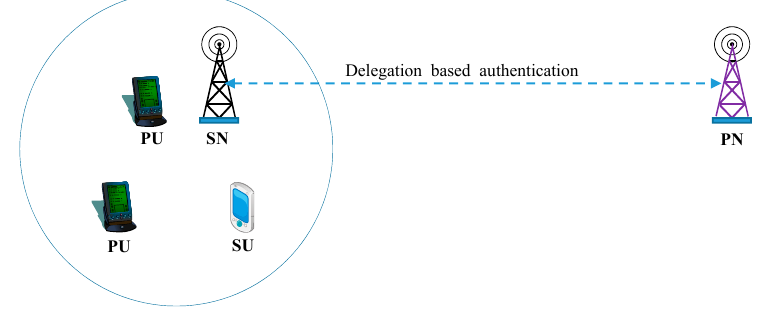
Figure 2. Assumed system model.